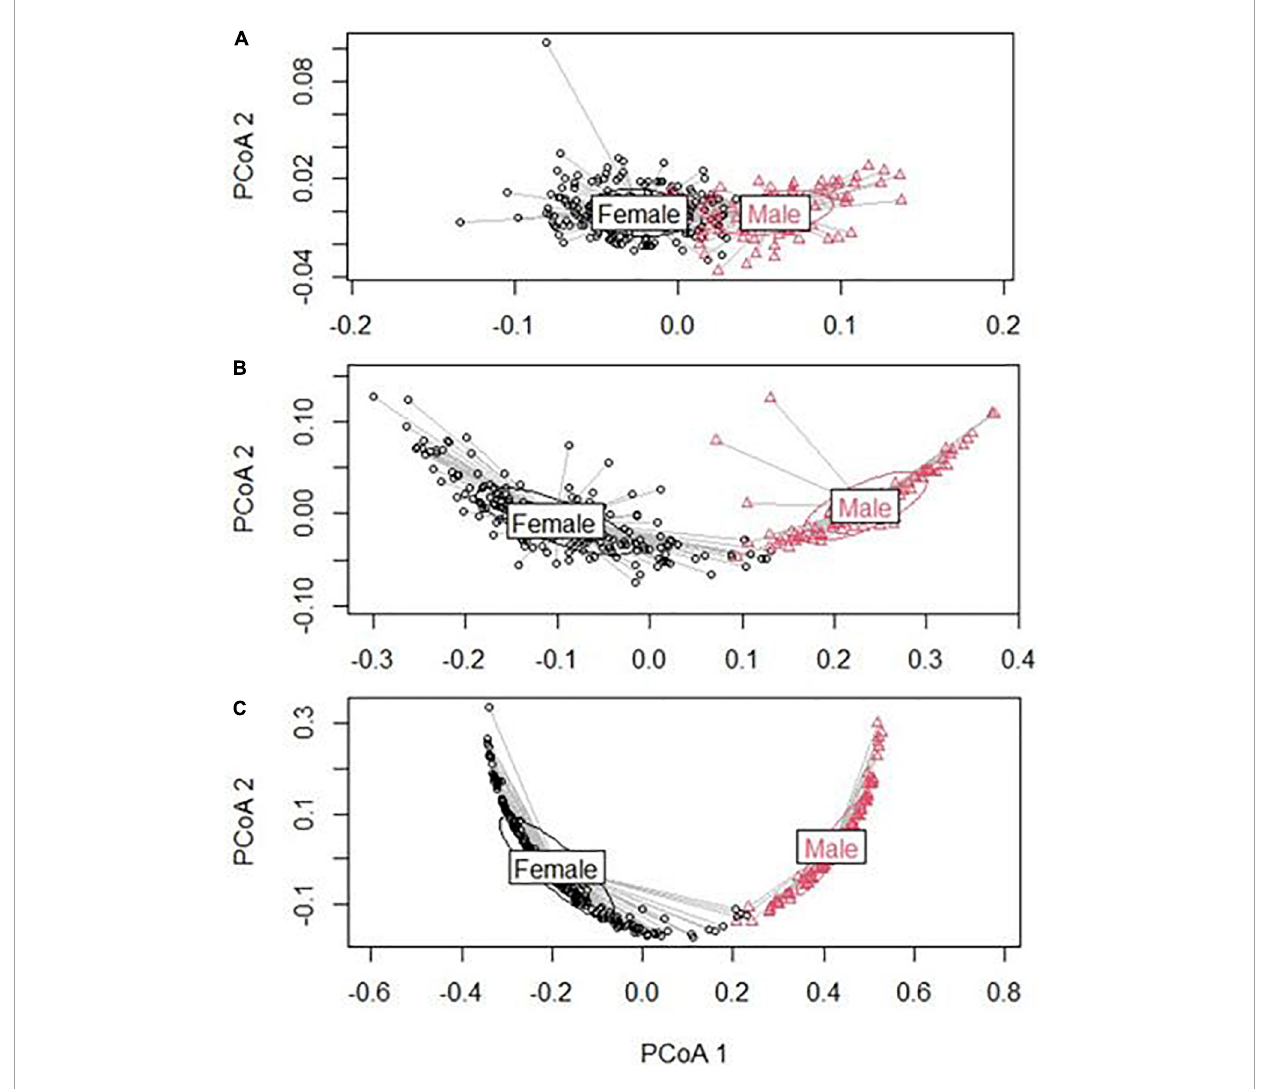
FIGURE3 Principal component analysis (PERMANOVA result) based on morphology data (male and female). (A) Morphology; (B) appendix length; and (C) appendix surface